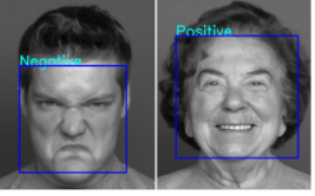
Figure 24. Accurately Classified Images 2 ×